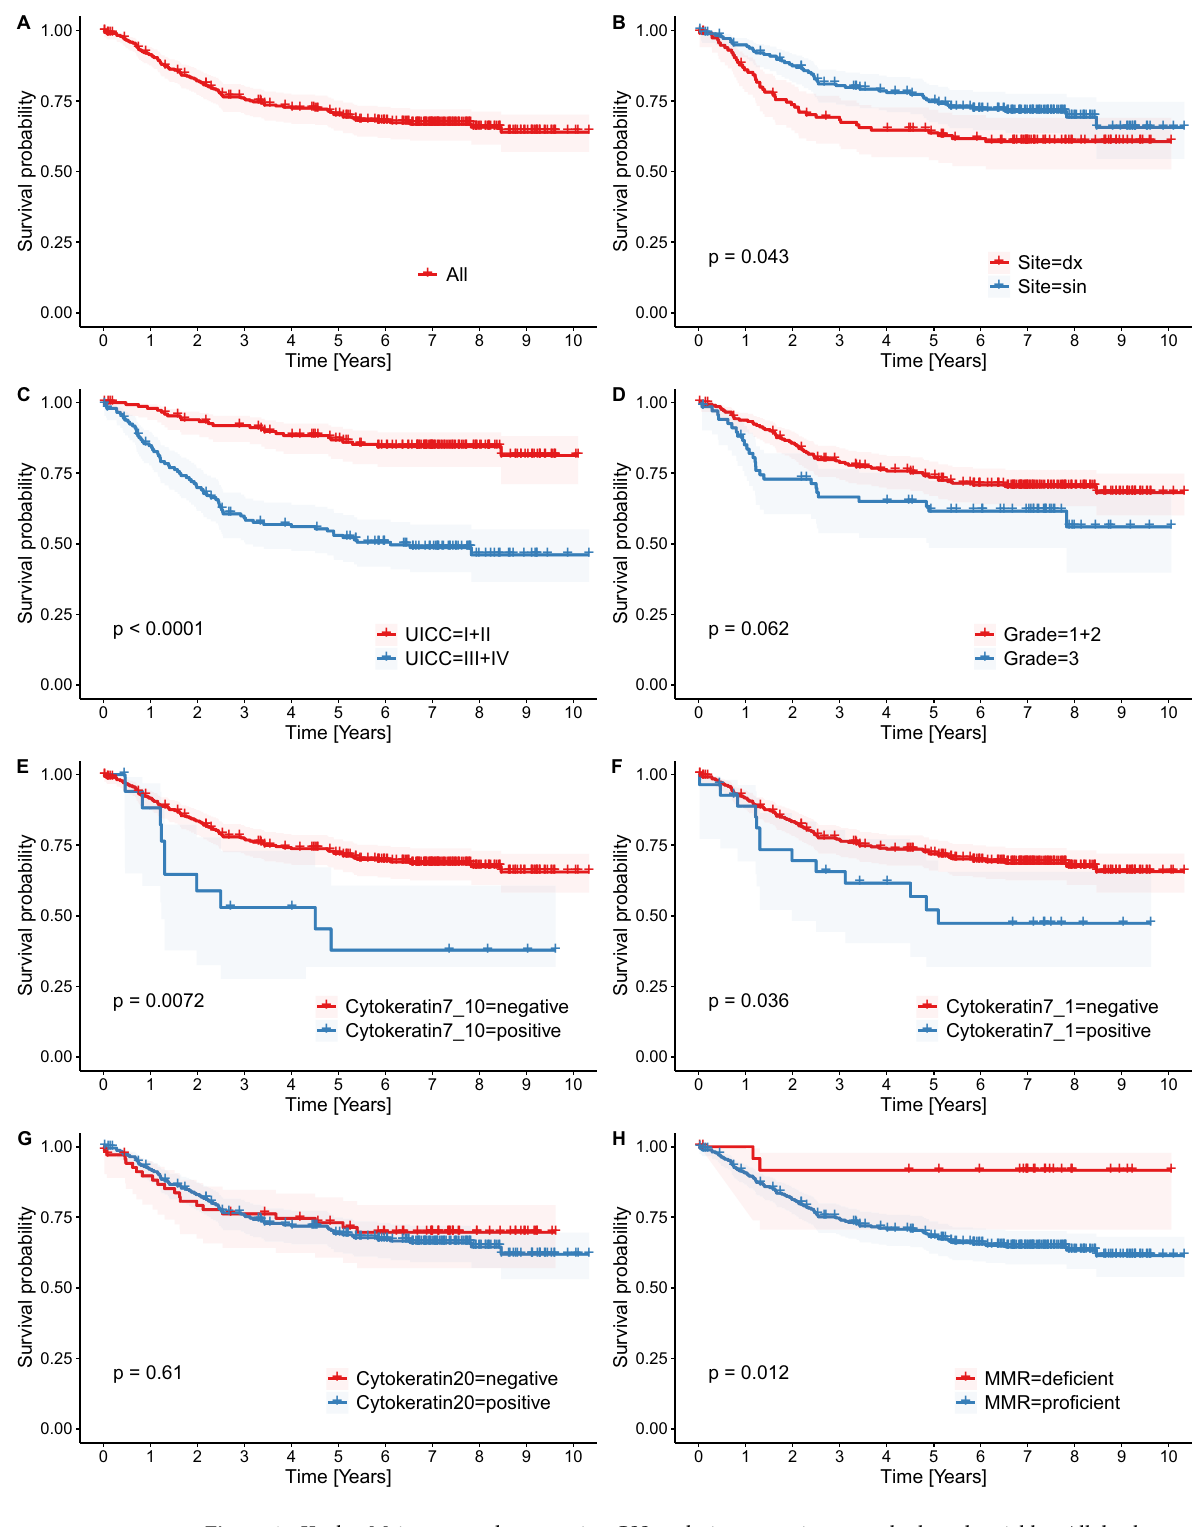
Figure 4. Kaplan Meier curves documenting CSS analysis concerning several selected variables. All death are showed in ( A ). There is a significantly worse survival in proximally situated tumors ( B ), advanced stage tumors ( C ), MMR-proficient tumors ( H ), CK7 + tumors using positivity cut-off on 10% ( E ) as well as on 1% ( F ). Using higher cut-off, the P -value is lower despite lower number of CK7 + cases (see discussion). Histopathological grade ( D ) is borderline insignificant despite visible trend in the curves. CK20 status ( G ) has no influence on